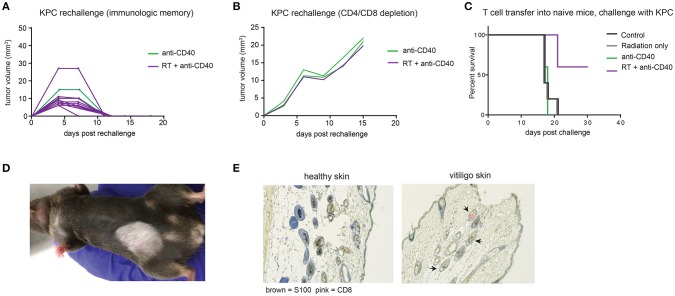
Combination RT and anti-CD40 induces immunologic memory and autoimmune vitiligo. (A) Mice from Figure 4 that were cured of their tumors by anti-CD40 or RT+anti-CD40 were rechallenged with 400,000 KPC cells in the absence of further treatment. (B) Mice from Figure 4 that were cured of their tumors were treated with depleting antibodies to CD4 and CD8 (100 μg every 3–4 days) and inoculated with 500,000 KPC cells. (C) Mice were treated as in Figure 4 with RT, anti-CD40 or RT+anti-CD40. Twelve days post treatment, spleens and lymph nodes were harvested, and total T cells isolated by magnetic bead selection. T cells from the indicated groups of donor mice were transferred into naïve recipient C57BL/6 mice that were then challenged with 200,000 KPC cells subcutaneously. Tumor growth was monitored until all mice were euthanized or tumor-free. (D) Representative picture of vitiligo development in combination treated mice that had been rechallenged with KPC tumors. (E) Histology of skin from an untreated mouse or a mouse with vitiligo shown in (C). Immunohistochemistry stains for CD8 (pink) and the melanocyte marker S100 (brown). Arrowheads indicate CD8 staining in the hair follicles. Representative of 3 mice per group.